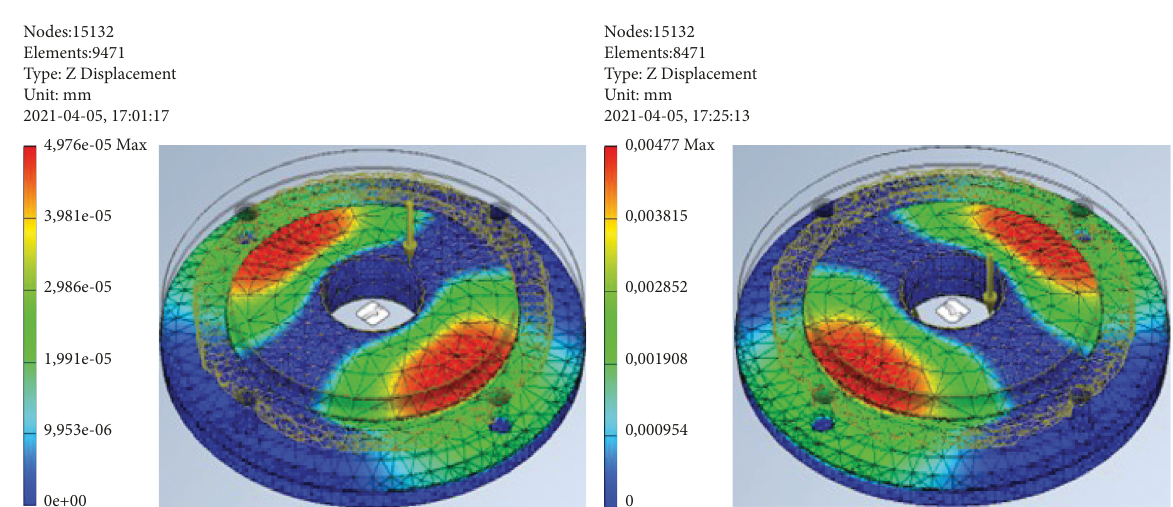
Figure 10: Topology optimized compliant C-clamp plate displacement– Z direction.